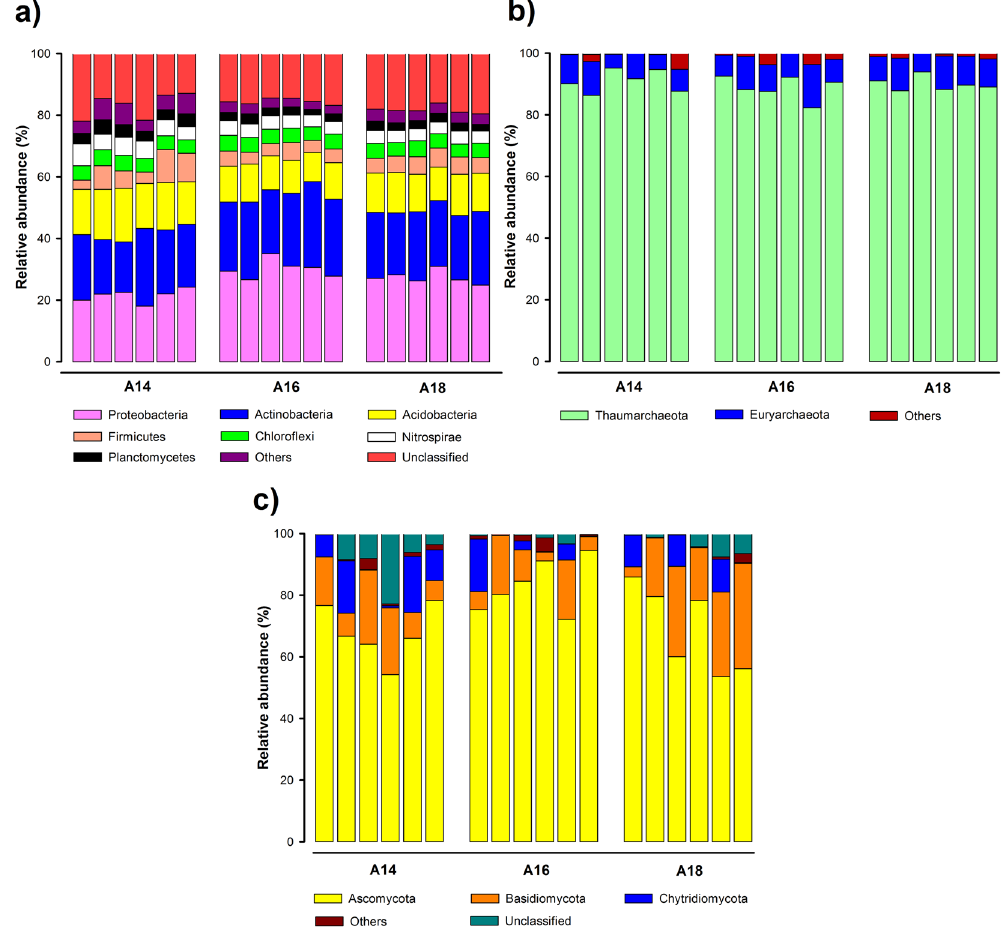
Figure 2. Relative abundance of bacterial ( a ), archaeal ( b ) and fungal ( c ) phyla found in the studied layers A14 (upper), A16 (intermediate) and A18